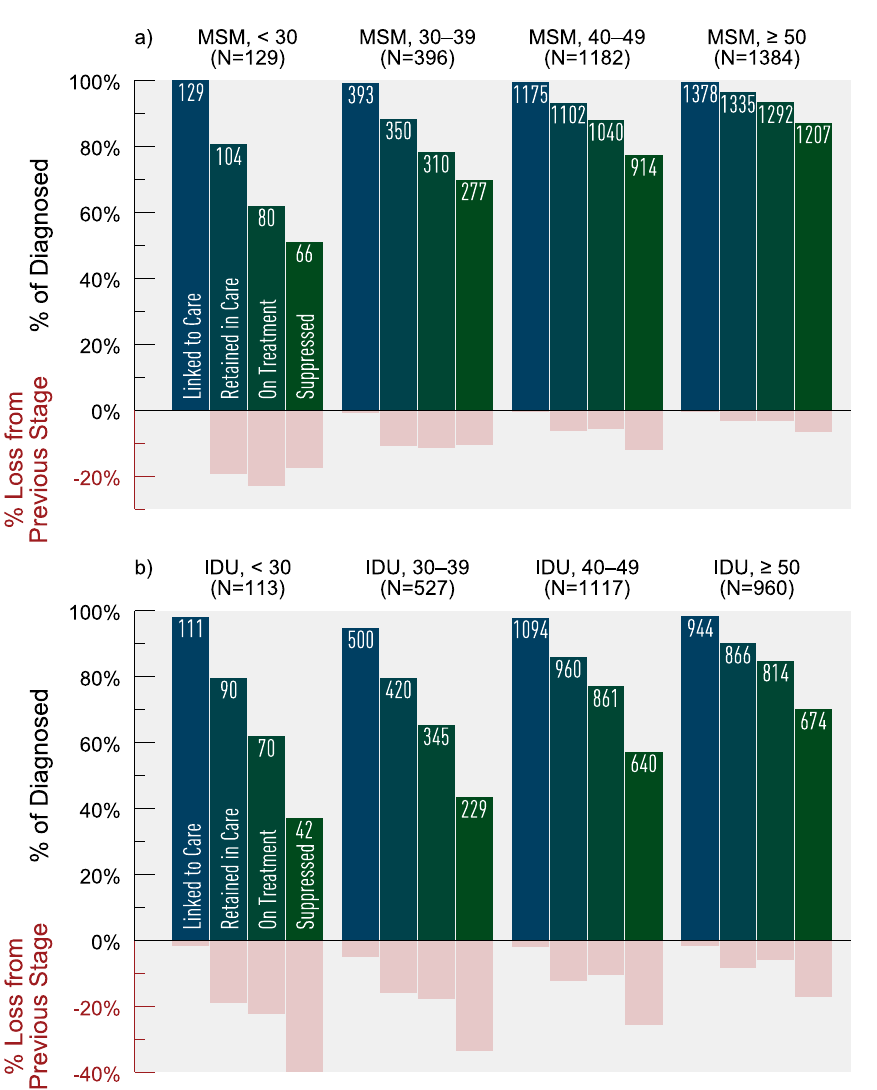
Fig. 5. Estimated HIV cascade of care for MSM by age category and IDU by age category in 2011 for British Columbia. *MSM 5 men who have sex men; IDU 5 history of injection drug use; Age is defined as age as of January 1 st ,